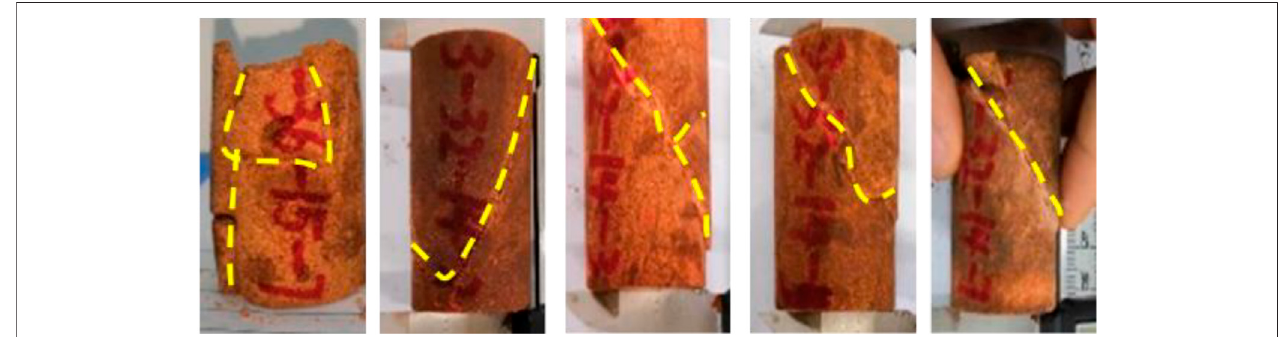
FIGURE 10 | The shape of sandstone specimens after failure in conventional triaxial compression.